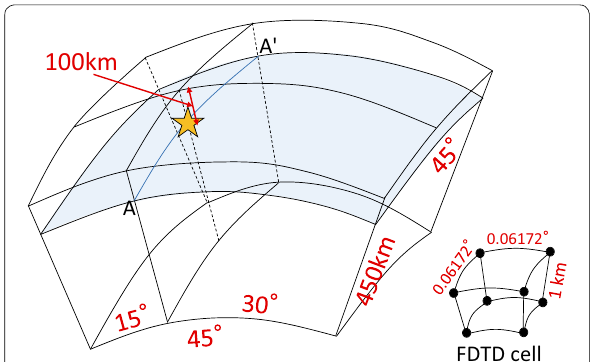
Fig. 4 Model setting for the Moon simulation. Location of the source ( star ) and the datum ( light blue -colored surface). Receivers are set at line A–A ′ ( blue line ) on the datum. This line also indicates location of cross section shown in Fig. 7 for the snapshots. A small curved cubic on the right side of the model schematically shows a grid cell for the computation by the quasi-Cartesian